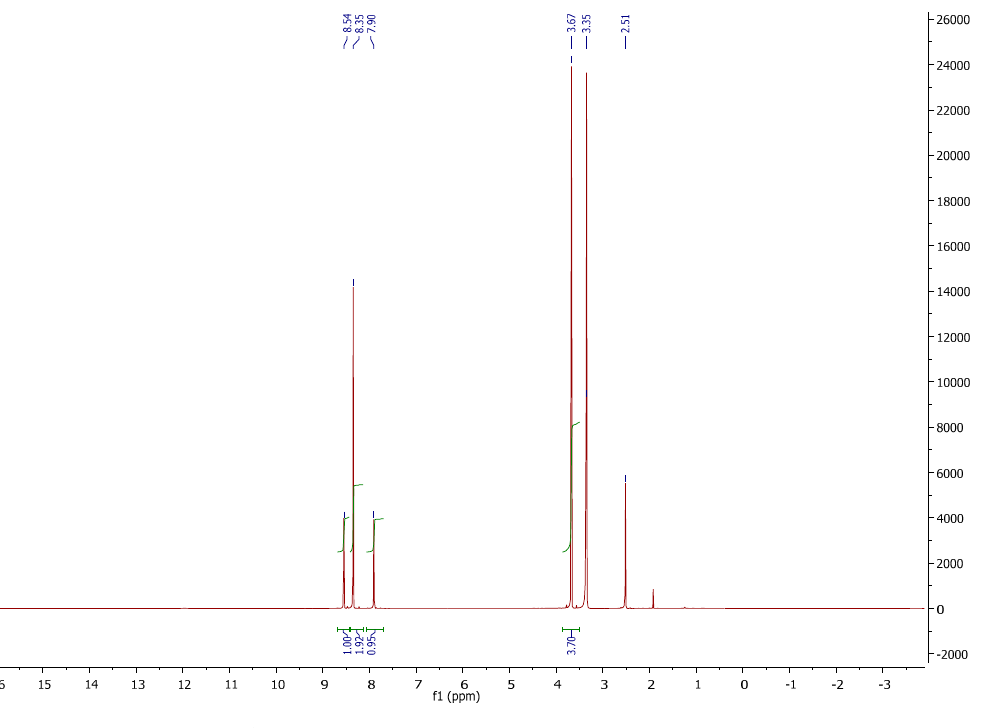
Figure 2. 1 H NMR spectrum (700 MHz, DMSO ‐ d 6 ) of compound 9.